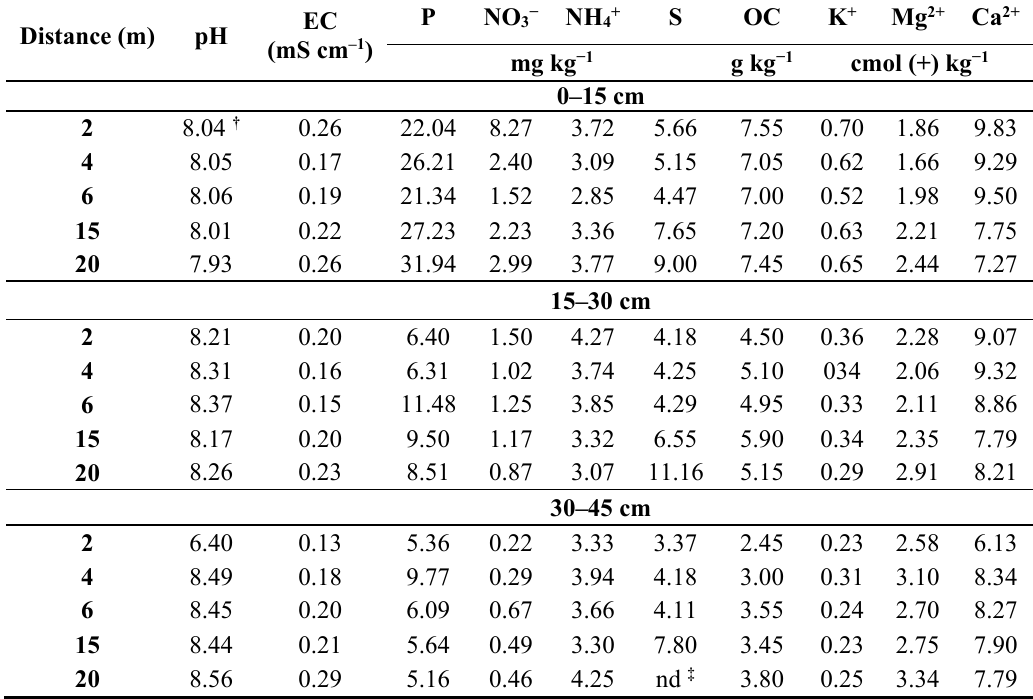
Table 1. Physiochemical properties of Orthic Oxbow soil at distances perpendicular to a caragana